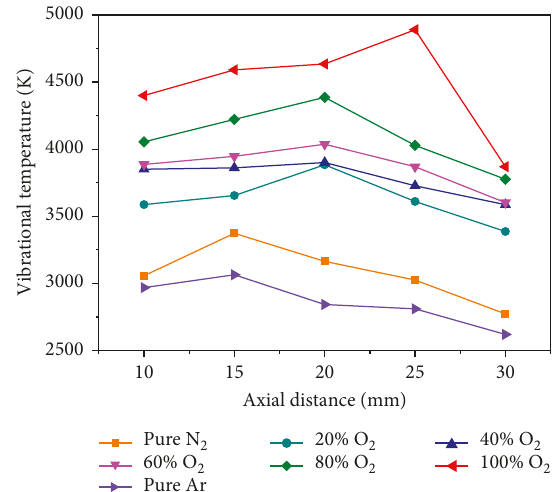
Figure 9: Axial spatial distribution of vibrational temperature of the plasma